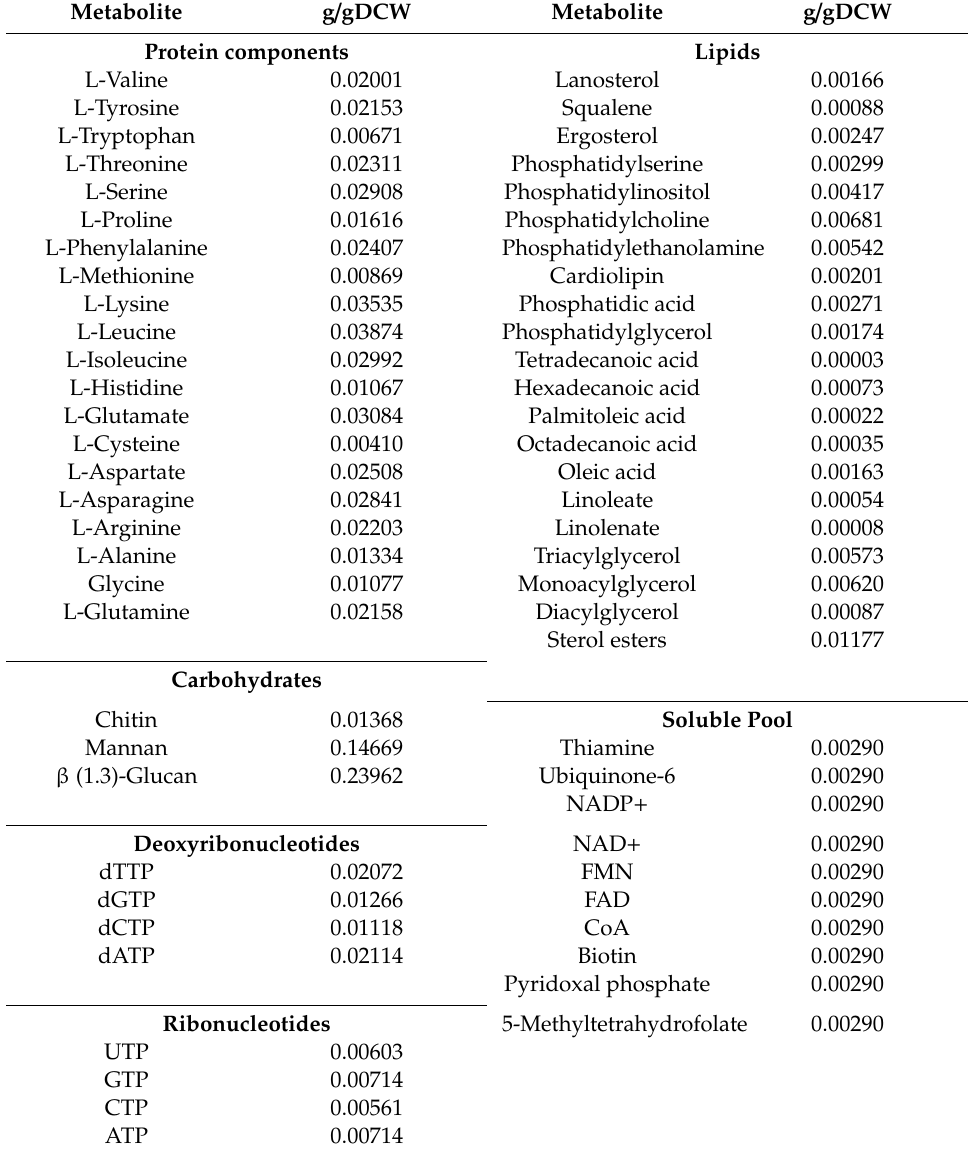
Table 2. Biomass Composition used in the model iRV781. More detailed information is found in File